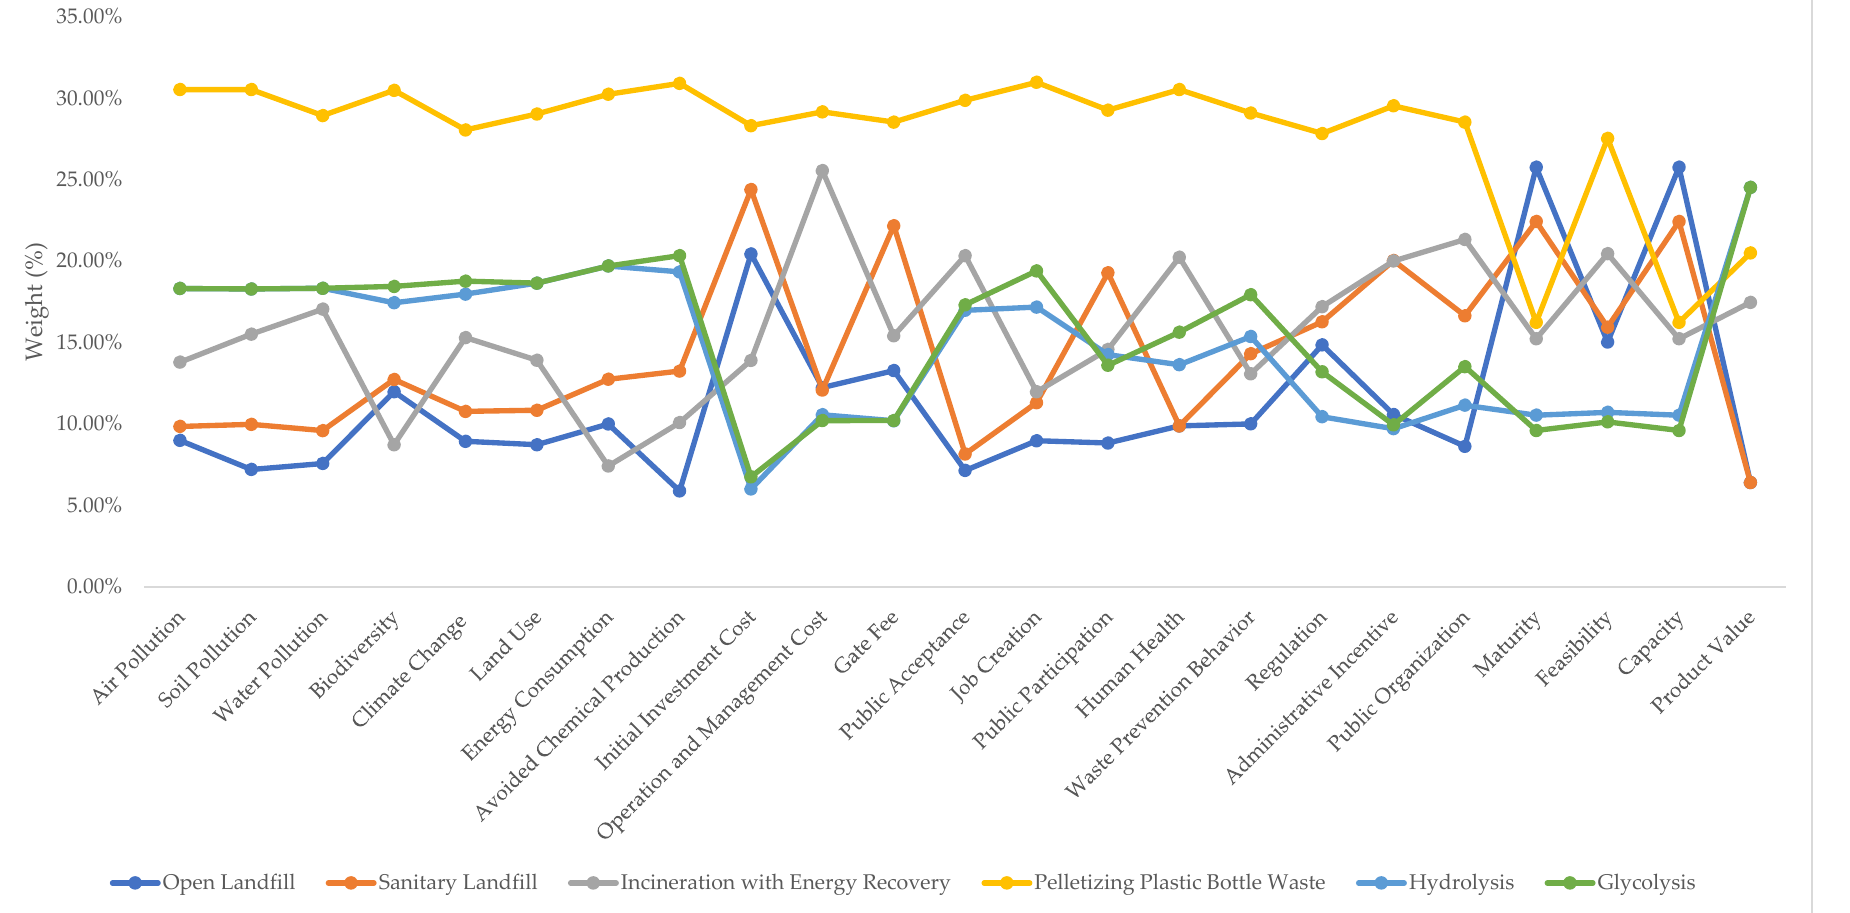
Figure 8. International experts’ subcriteria judgment results for the alternatives (%).